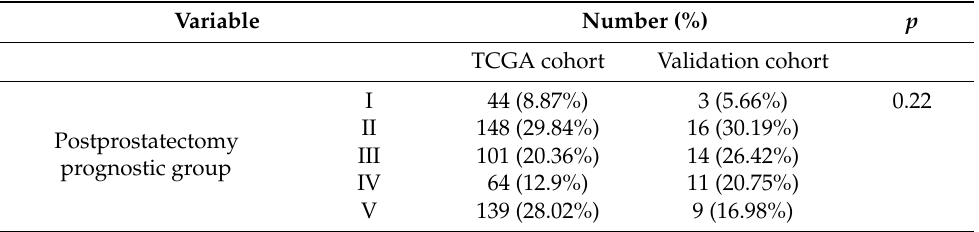
Table 3. Postprostatectomy characteristics of TCGA cohort and validation cohort used for immuno-